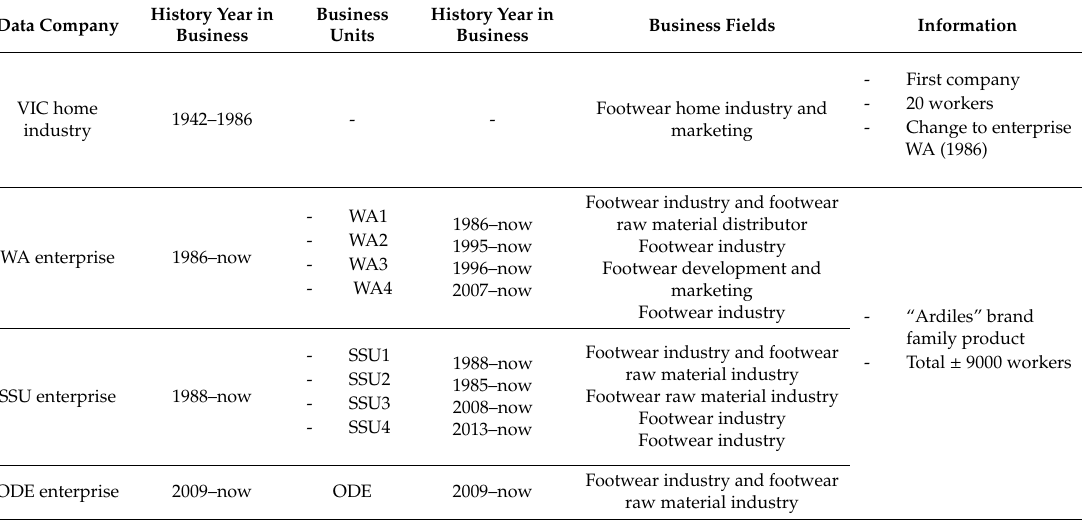
Table 1. Anonymized data of the “Ardiles” family company, business units, years of establishment, and business